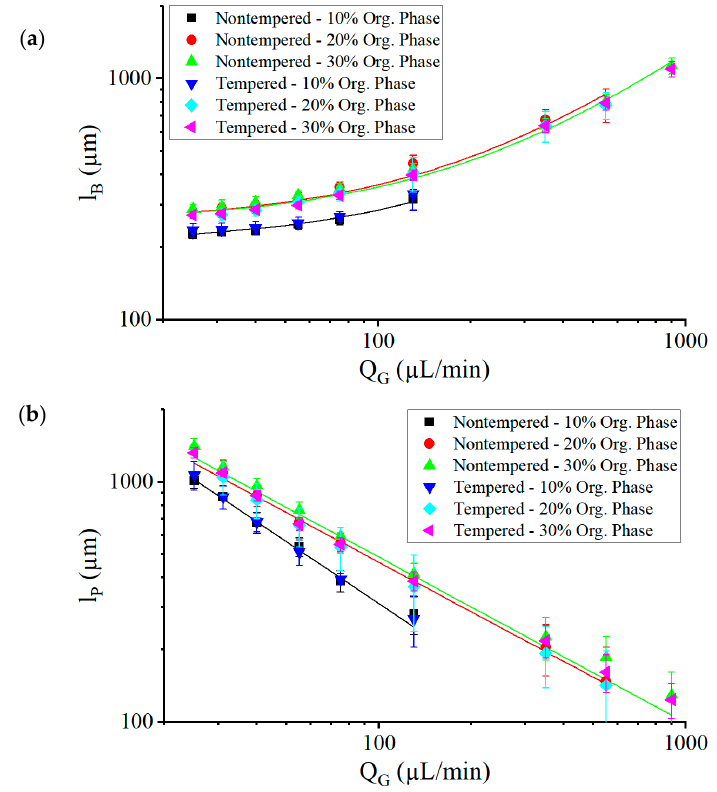
Figure 7. The lengths of the gas bubbles l B ( a ) and plugs l P ( b ) obtained in the experiments with nontempered and tempered systems as a function of the gas volume flow Q G at a total liquid volume flow Q L of 200 µ L/min. The trend lines are shown simply to guide the reader’s eye.